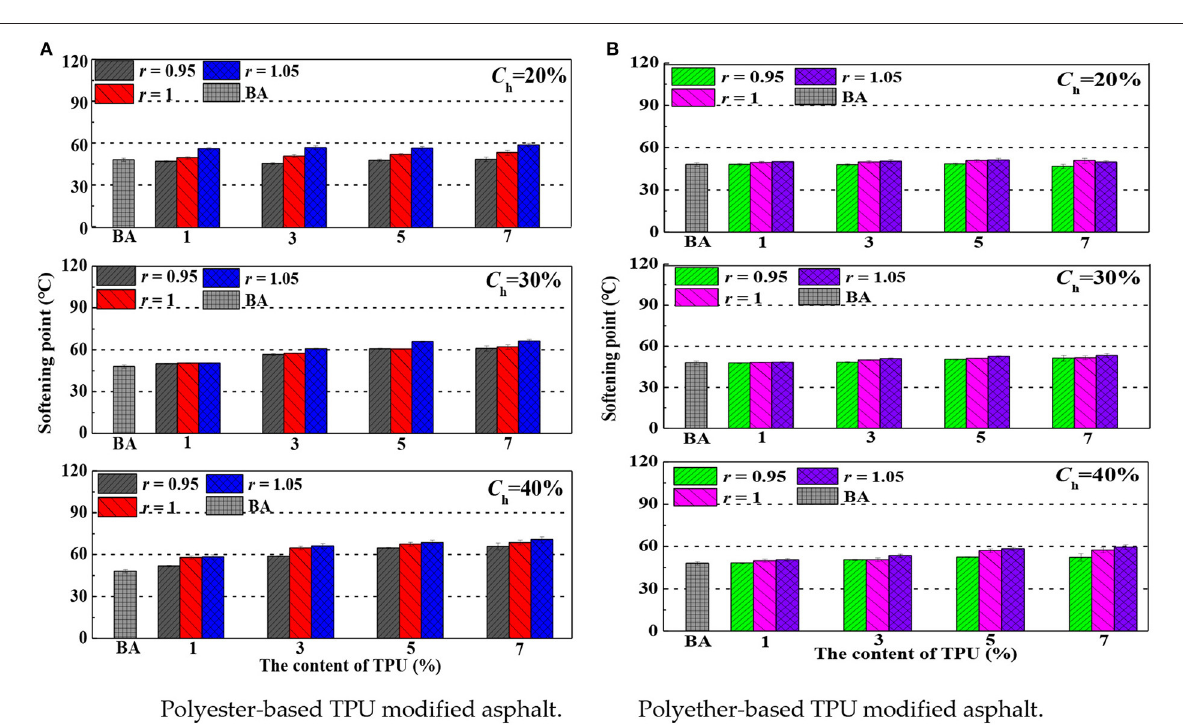
Frontiers in Materials |